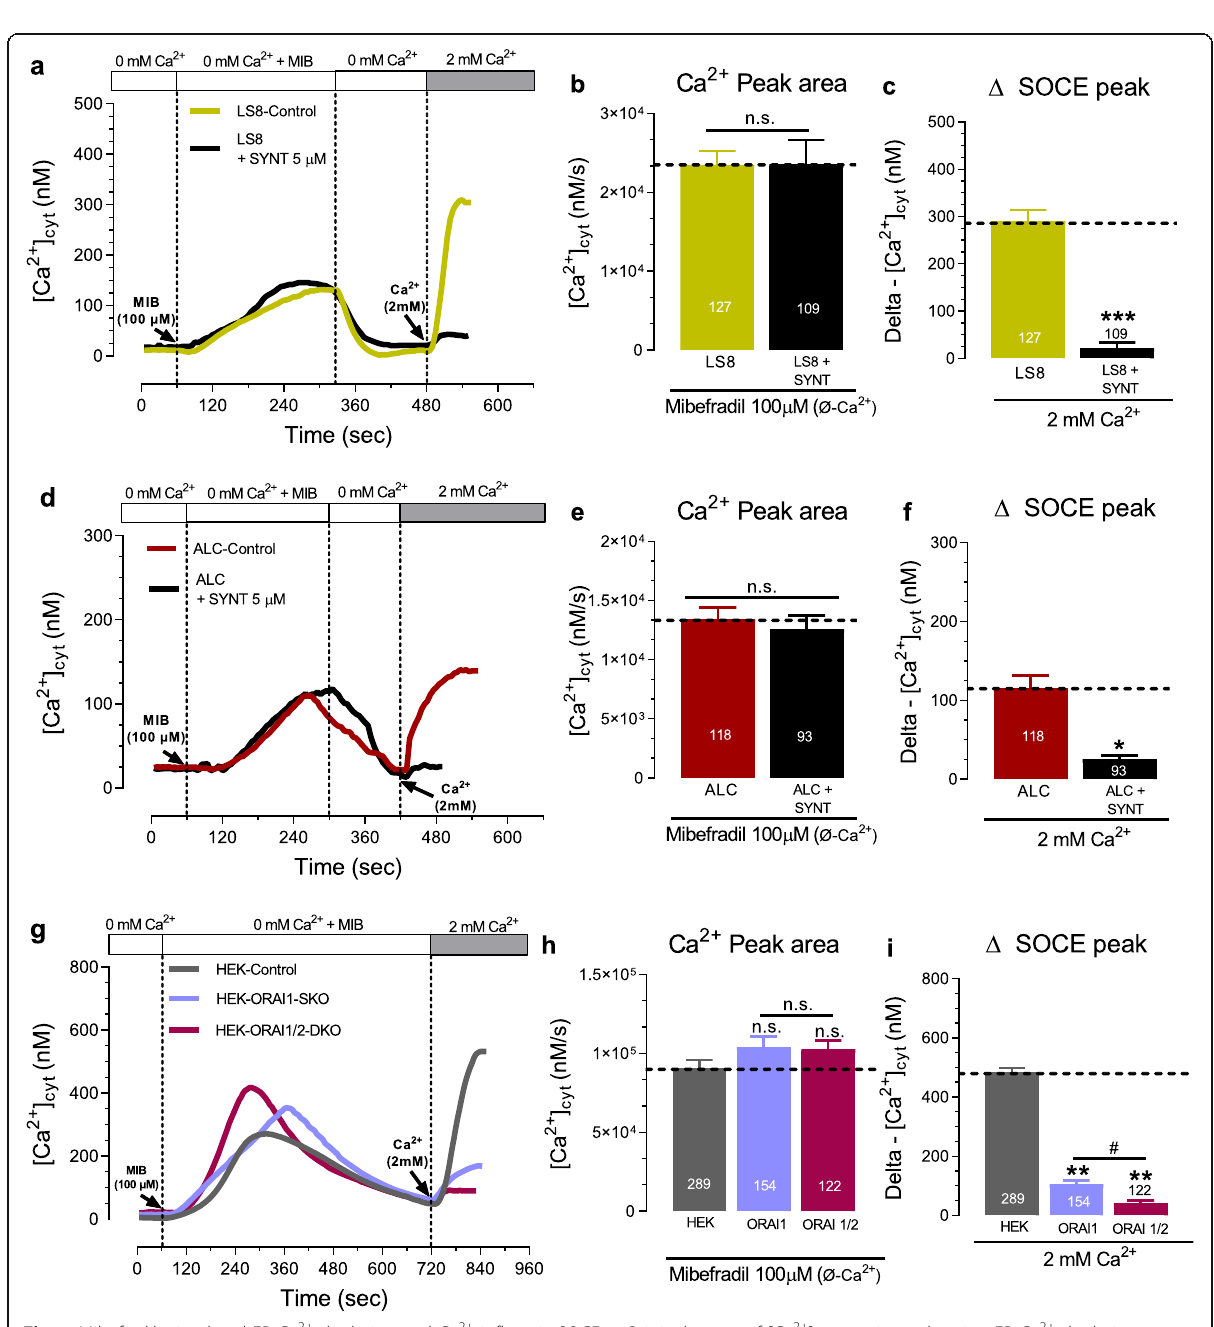
Fig. 5 Mibefradil stimulated ER-Ca 2+ depletion and Ca 2+ influx via SOCE. a Original traces of [Ca 2+ ] cyt transients showing ER-Ca 2+ depletion elicited by mibefradil (100 μ M) in Ca 2+ -free Ringer ’ s solution followed by readdition of 2 mM extracellular Ca 2+ solution in LS8 cells with or without pre-incubation with synta-66. b Quantification of the ER-Ca 2+ release peak area under mibefradil stimulation. c Quantification of Δ SOCE peak upon readdition of 2 mM Ca 2+ . d Same as in a-c but in ALC cells. g Original traces of [Ca 2+ ] cyt transients showing ER-Ca 2+ depletion elicited by mibefradil (100 μ M) in Ca 2+ -free Ringer ’ s solution followed by readdition of 2 mM extracellular Ca 2+ solution in HEK-293 cells with a CRISPR- cas9 deletion of ORAI1 (SKO) or dual deletion of ORAI2 and ORAI2 (DKO). h Quantification of the ER-Ca 2+ release peak area under mibefradil stimulation. i Quantification of Δ SOCE peak upon readdition of 2 mM Ca 2+ . Data represent the mean ± SEM of ≥ 93 cells from 3 independent experiments. Data were analyzed by two-tailed unpaired Student ’ s t-test or one-way ANOVA followed by Tukey ’ s multiple comparison post-hoc test. * P < 0.05 vs. ALC group; ** P < 0.01 vs. HEK-control group; *** P < 0.001 vs. LS8 group; # P < 0.05 vs. HEK-ORAI1 group; n.s.,